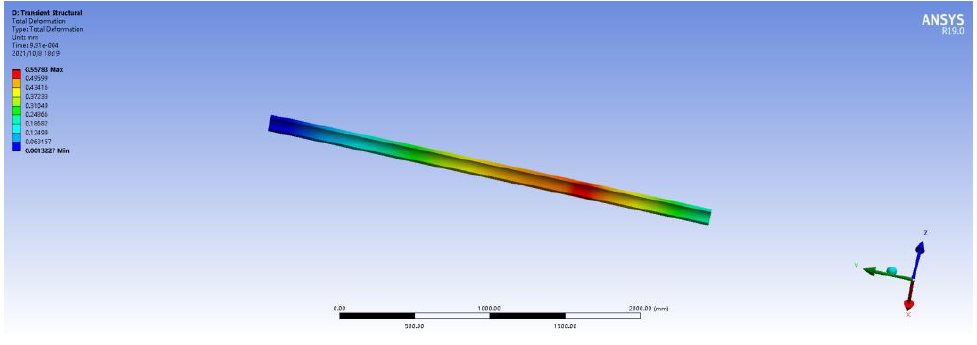
Figure 9. Total deformation of Cr coating barrel.